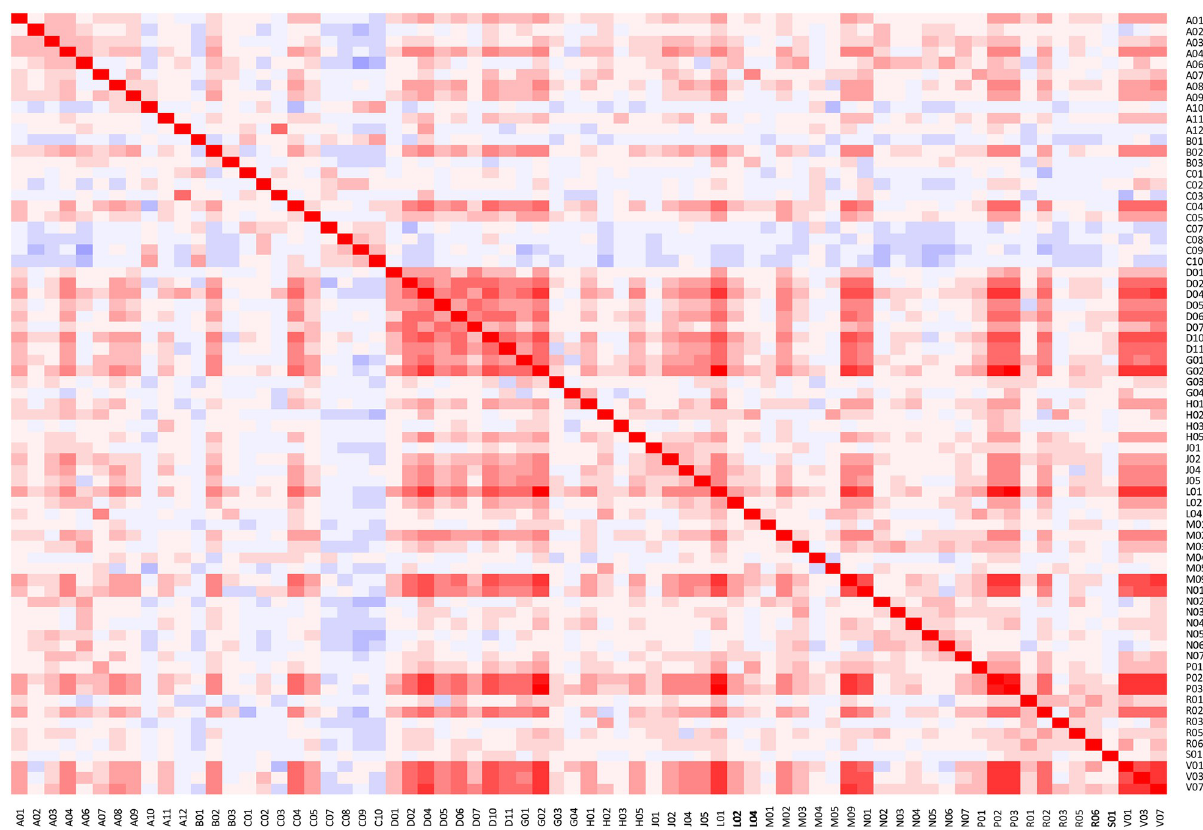
Fig 2. Heatmap of correlations between medications among polypharmacy-exposed participants at the time of inclusion.